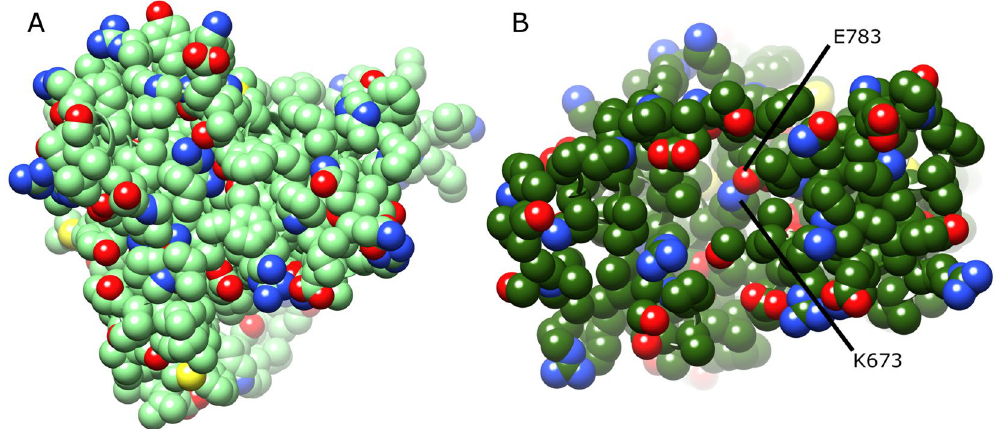
Figure 11. Comparison of average conformations of ( A ) apo mGlu4 without MPEP (green) and ( B ) mGlu4 with bound MPEP (dark green) obtained from 2.5–5 µ s respective MD simulations. Receptors are viewed from their intracellular side with atoms displayed as spheres. Residues participating in the ionic-lock are labelled in ( B